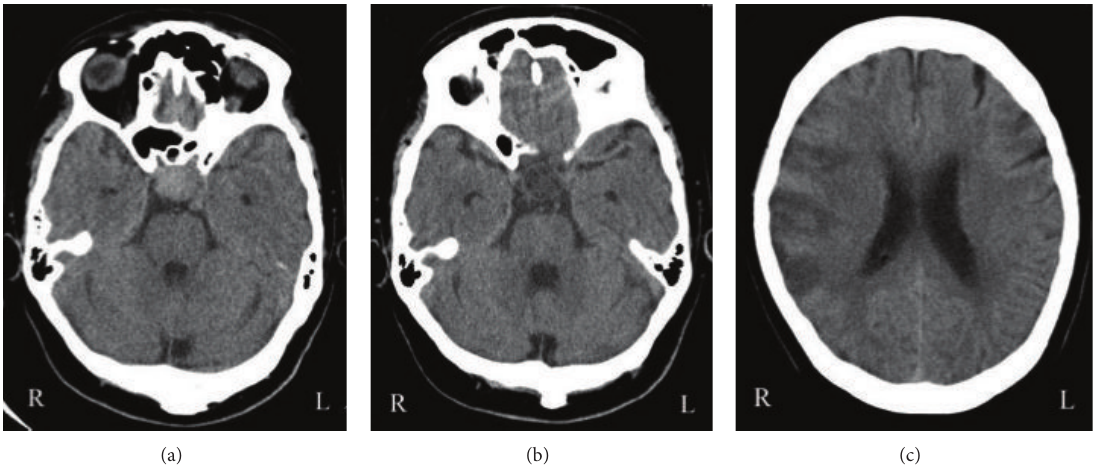
Figure 1: (a) Axial view of the CT showing the round and slightly hyperdense area in the suprasellar region at the first emergency visit. (b, c) Axial view of the CT showing the round hypodense area in the suprasellar region and the low density area in the territory of the right middle cerebral artery at the second emergency